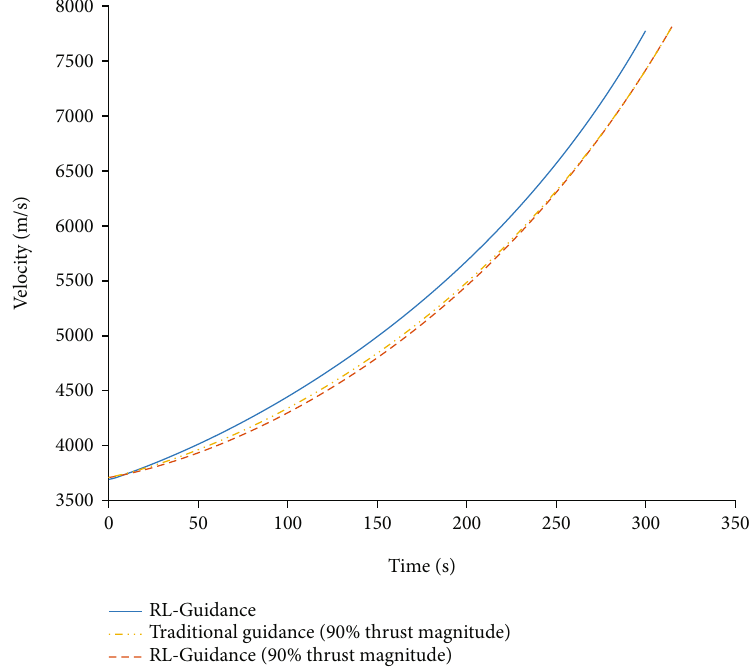
Figure 11: Velocity comparison of RL-guidance and traditional guidance in experiment 2.